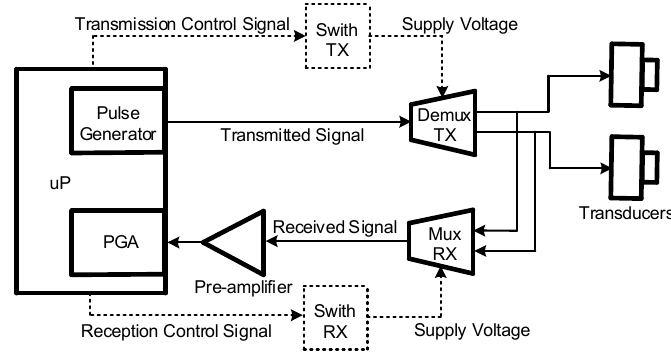
Figure 21. Hardware block diagram.